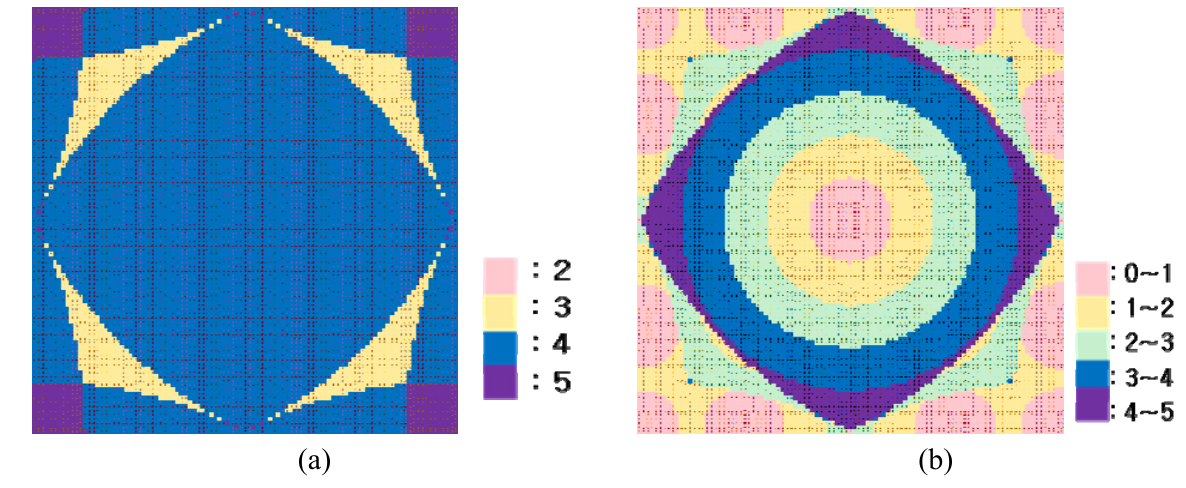
Figure 11. (a) Number of detected tags in worst case (b) Scale of error in worst case.